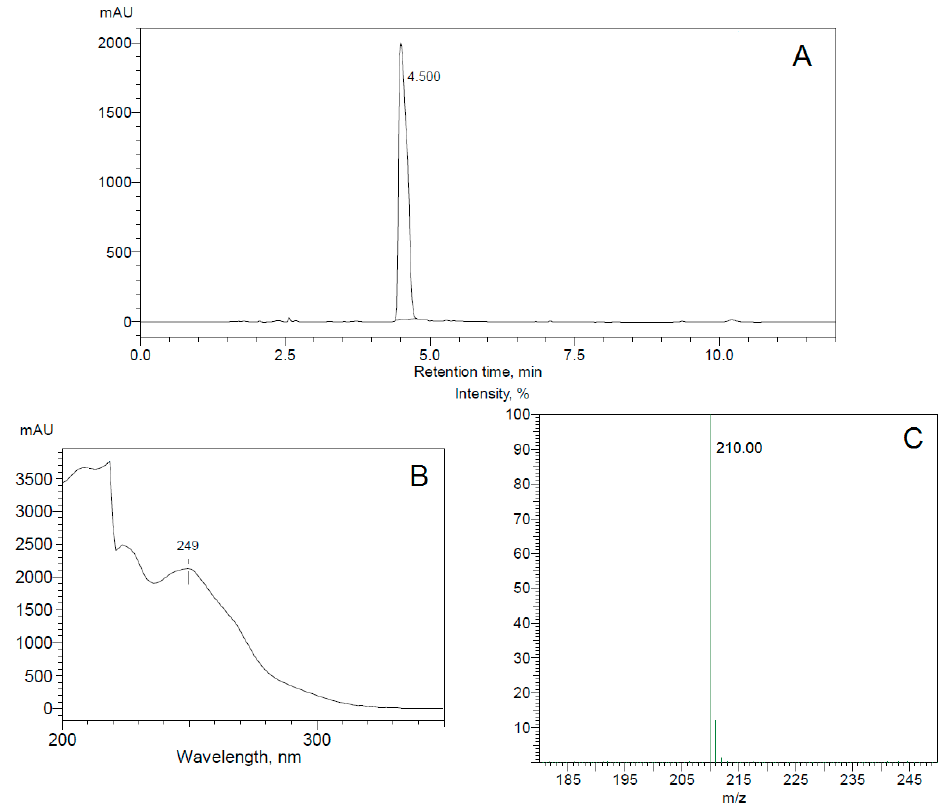
Figure 6. HPLC-MS analysis of 3-(2,4-dihydroxyphenyl)-propionic acid bioconversion mixture in vivo. UV 254 nm trace of picolinic acid derivative with retention time of 4.500 min ( A ), UV spectrum ( B ) and MS spectrum ( C ) of the dominant peak. The negative ions [M − H] − generated are at m / z 210.00.